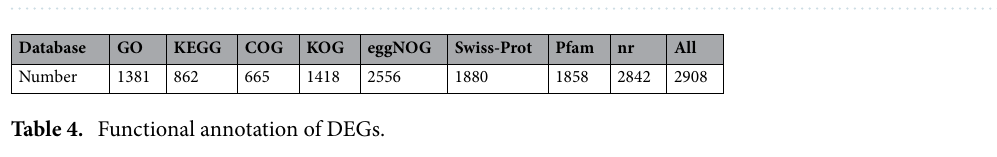
Figure 2. Number and functional annotation of DEGs. ( a ) Volcano plot. ( b ) GO classification. ( c ) KEGG class. ( d ) KEGG pathway enrichment map.